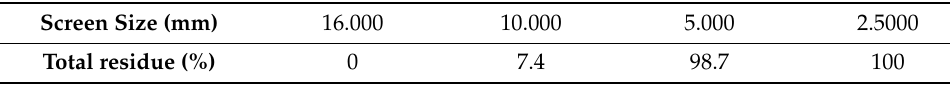
Table 5. The gradation of coarse aggregates used in this study.